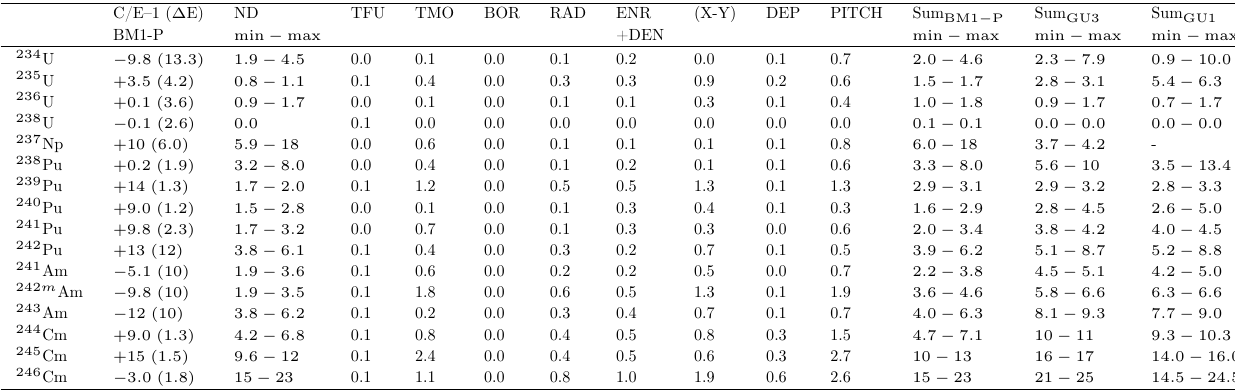
Table B.9. Summary of all uncertainties in % (or 1 σ ) for the BM1-P sample with the assembly model considered in this study for actinides. For nuclear data, the range from Table B.7 is presented here. The “Sum” column corresponds (cid:112)(cid:80) ∆ 2 ( C i ) for calculated uncertainties. The sums for the GU1 and GU3 samples are also indicated (without the to i systematic effect of 2% for the mass balance of GU1). See text for the description of the columns.